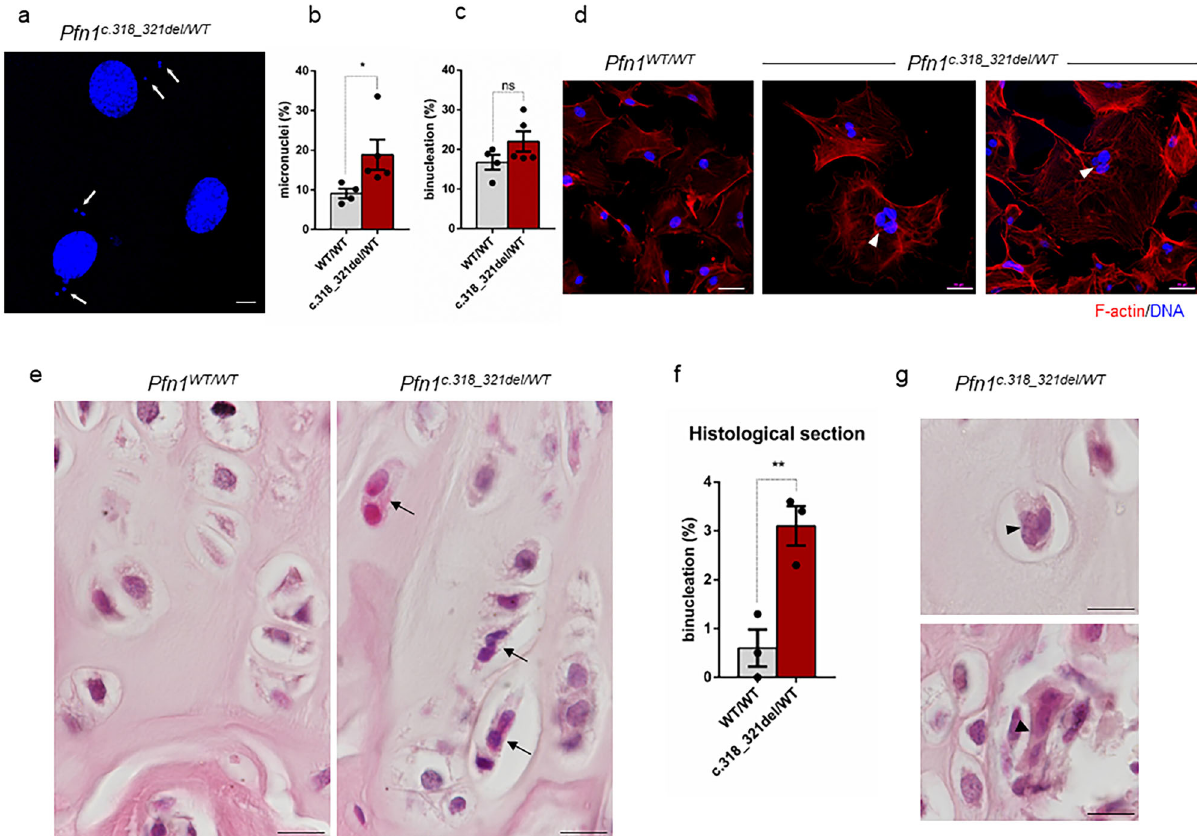
Fig. 6 Pro fi lin 1 insuf fi ciency underlies cell division defects in vivo. a Representative images of micronuclei (white arrows) in mesenchymal cells isolated from the calvarias of Pfn1 knock-in (c.318_321del/WT) mice; scale bar 10 µ m. b Quanti fi cation (%) of micronuclei in normal (WT/WT) and Pro fi